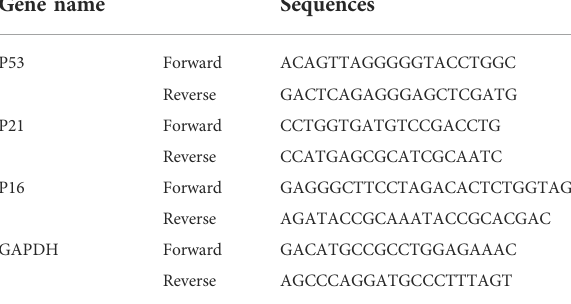
TABLE 2 Primer sequences used for